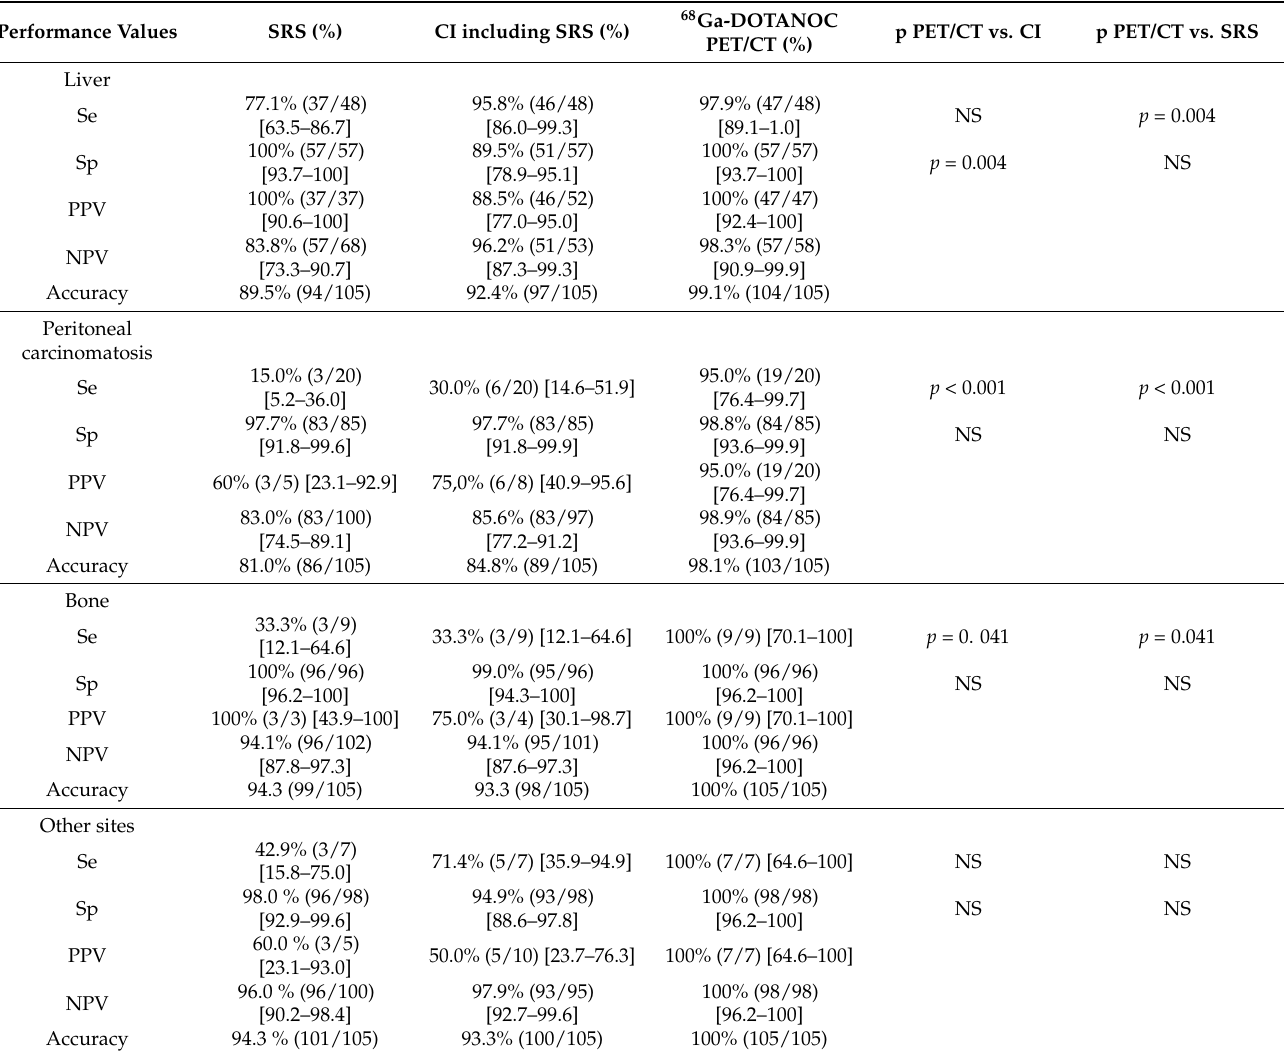
Table 5. Sensitivities, specificities, positive predictive values, negative predictive values, and accura- cies of Optimized Octreoscan ® scintigraphy, Conventional Imaging and 68 Ga-DOTANOC PET/CT at metastatic sites’